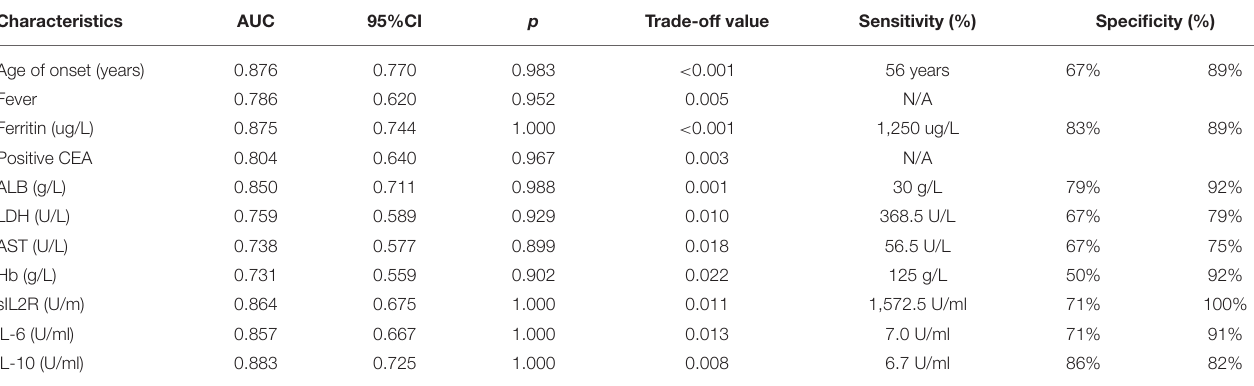
TABLE 4 | ROC curve analyses between non-survivors and survivors with anti-MDA5-positive DM.